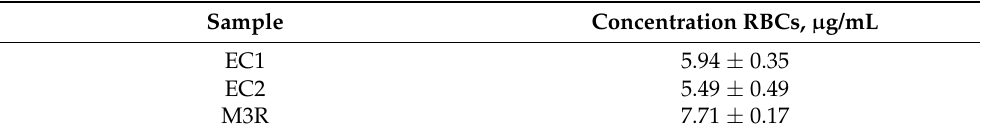
Table 4. Concentration of EC1, EC2 and M3R responsible for 50%